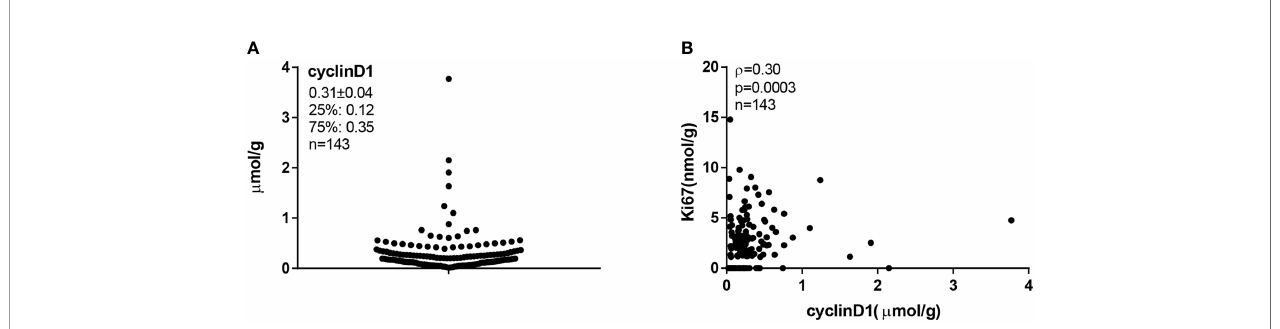
FIGURE 2 | The cyclinD1 protein levels in 143 Luminal-like breast cancer formalin- fi xed paraf fi n-embedded (FFPE) specimens. A total of 143 Luminal-like breast cancer FFPE tissues provided as 2 × 15- m m slices were collected sequentially and nonselectively from a local hospital, and the total protein lysates were prepared as described in “ Materials and Methods ” . MCF-7 cell lysate was used as internal control. FFPE tissue lysates (about 0.35 m g/unit) and cell lysate (about 0.08 m g/unit) were applied onto the Quantitative Dot Blot (QDB) plate at 2 m l/unit in triplicate for QDB analysis using anti-cyclinD1 antibody EP12. Serially diluted cyclinD1 recombinant protein was included in each plate as protein standard. All results were averages of three independent experiments, with each sample in triplicate. (A) The cyclinD1 levels were from 0.02 to 3.77 m mol/g, with a mean at 0.31 m mol/g and a median at 0.21 m mol/g. (B) The correlation between cyclinD1 and Ki67 protein levels in 143 FFPE tissues was analyzed with Spearman ’ s correlation coef fi cient analysis using Graphpad software, r = 0.30, p